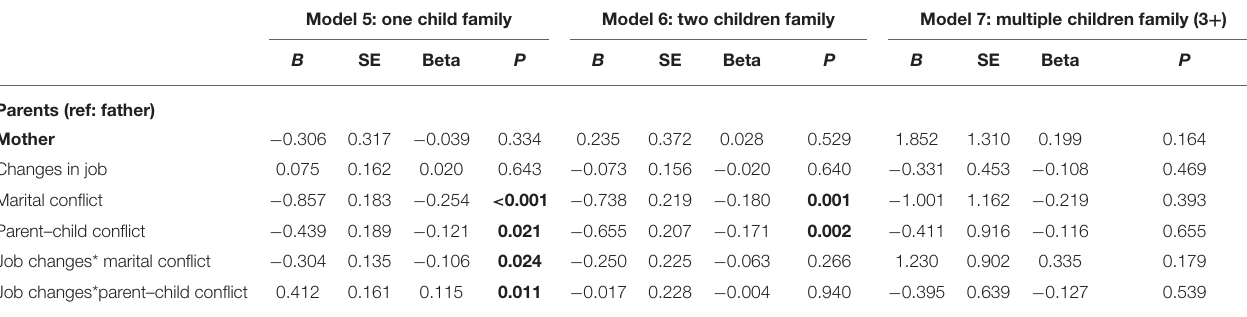
TABLE 5 | Interaction effects analysis between job changes and family conflicts on quality of life in the number of children subgroup. Model 5: one child